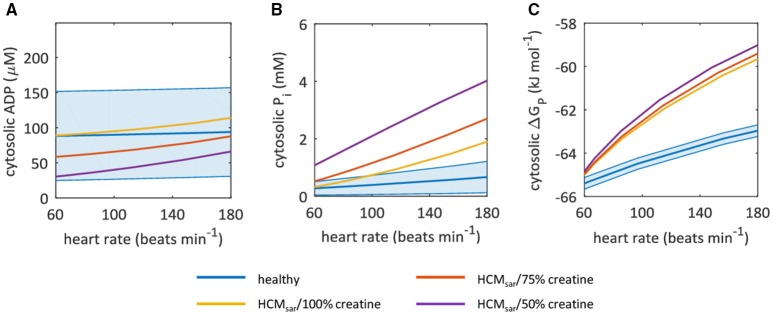
Sarcomeric energy inefficiency leads to an increase in myocardial cytosolic Pi concentration for high cardiac work rates. Graphs show computational model-based predictions of myocardial energy homeostasis over a range of cardiac work rates for the healthy heart (blue) and for hypertrophic cardiomyopathy due to sarcomeric energy inefficiency (HCMsar) with 100% (yellow), 75% (red), and 50% (purple) of the normal creatine pool size. The solid curve represents the mean of the simulation results while the shaded region reflects the model uncertainty (95% confidence intervals). Resting-state mean and confidence intervals are based on empirical 31P-MRS measurements and associated coefficient of variation for 3D ISIS. (A) cytosolic ADP concentrations. (B) cytosolic Pi concentrations. (C) Gibbs free energy available from ATP hydrolysis ΔGP. ADP, adenosine diphosphate; ISIS, image-selected in vivo spectroscopy; Pi, inorganic phosphate.